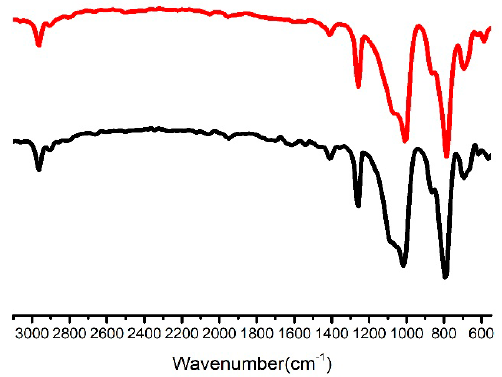
Figure 12. Infrared (IR) spectra of the original silicone (Si) film (lower black line) and the Si PI-surface film with the plasma discharge (upper red line).